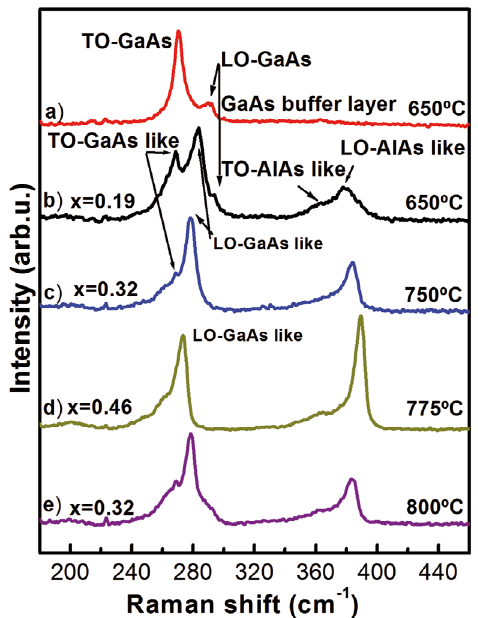
Ga As epilayers grown at several Figure 5: Raman spectra of Al x 1-x temperatures by MOCVD using metallic arsenic as precursor. The Al composition values were calculated using the Eqs. (1) and (2), whose values are x~0.19 (b), x~0.32 (c), x~0.46 (c) and x~0.46